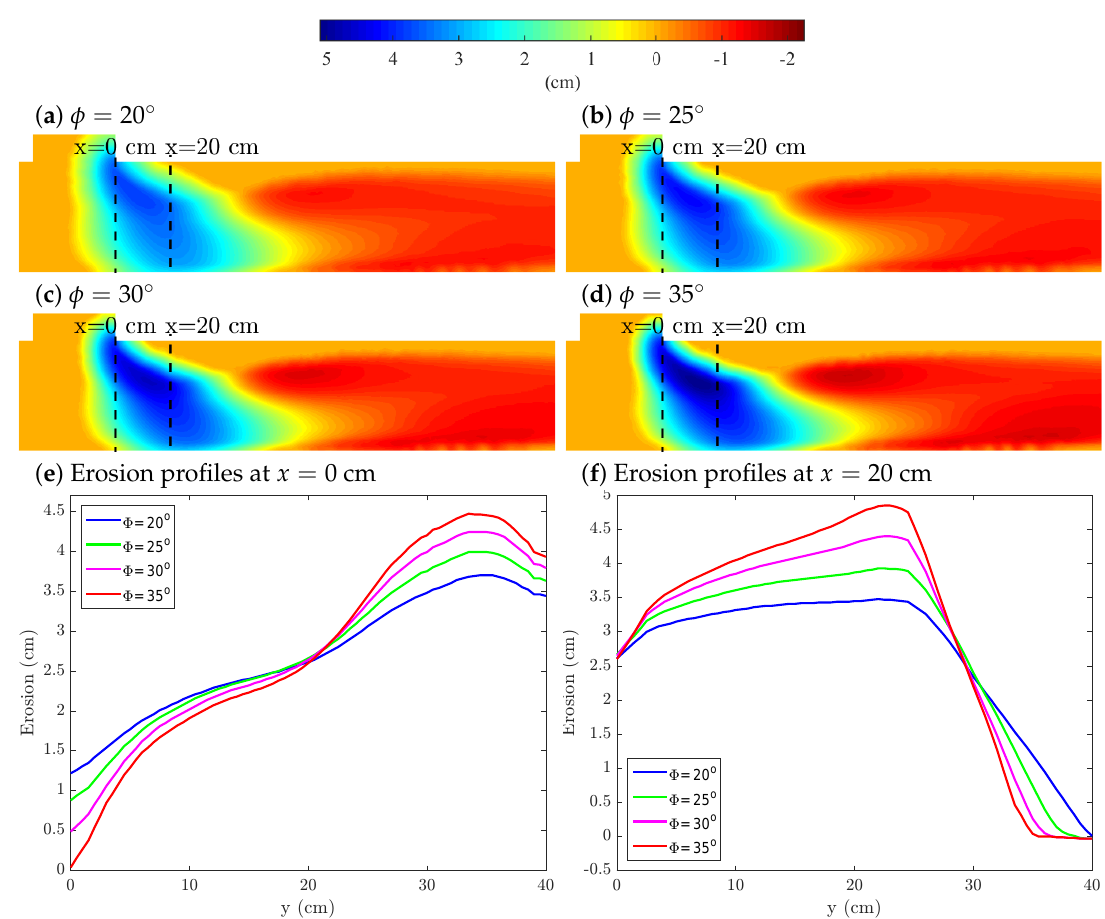
Figure 6. Effect of the friction angle of sediment on the erosion pattern. We plot the erosion contour plot for four friction angles, φ : in panel ( a ) φ is 20 ◦ , in panel ( b ) φ = 25 ◦ , in panel ( c ) φ = 30 ◦ , and in panel ( d ) φ = 35 ◦ . We plot two erosion profiles of the main channel at x -coordinate 0 cm in panel ( e ) and x = 20 cm in panel ( f ). The reference system is depicted in Figure 3a. Erosion is positive and sedimentation